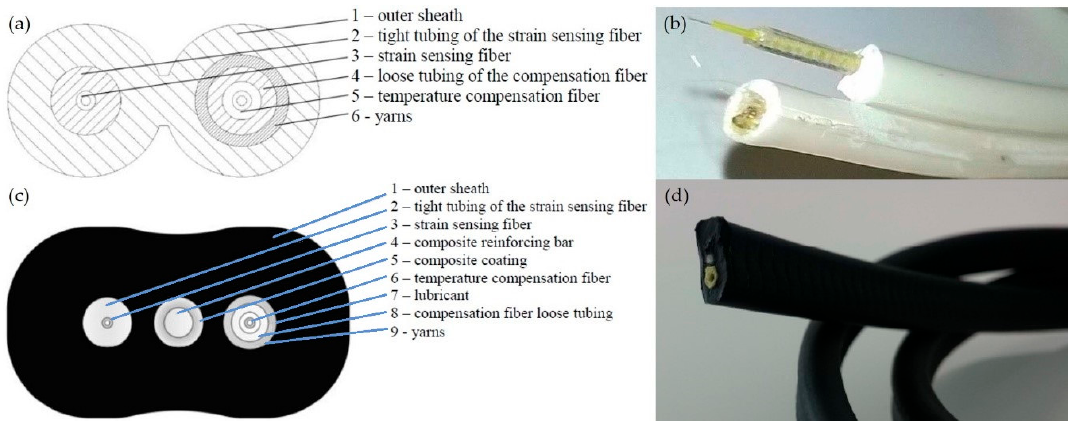
Figure 1. First cable prototype conceptual layout ( a ) and manufacturing design ( b ). Second cable prototype conceptual layout ( c ) and manufacturing design ( d ).